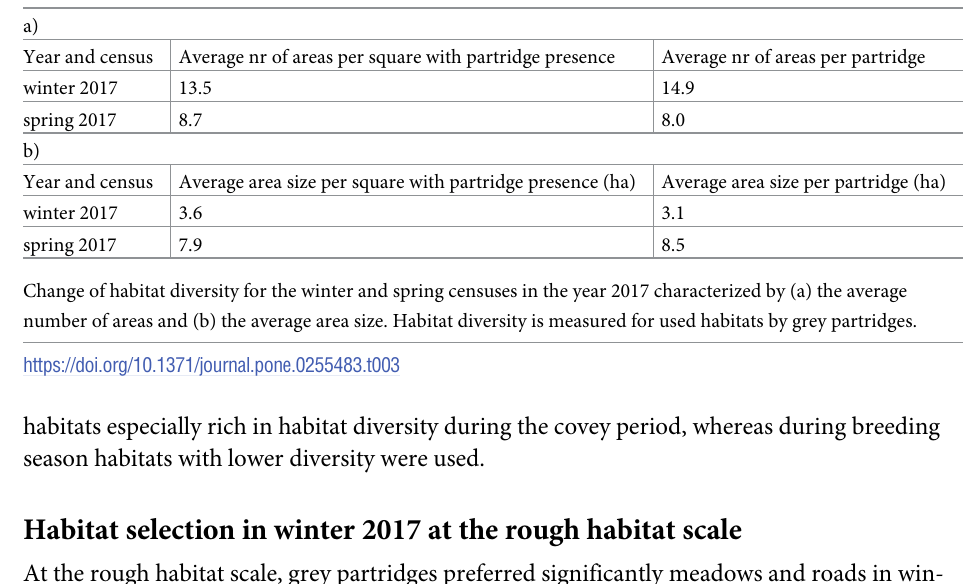
Table 3. Change of habitat diversity for winter and spring censuses in